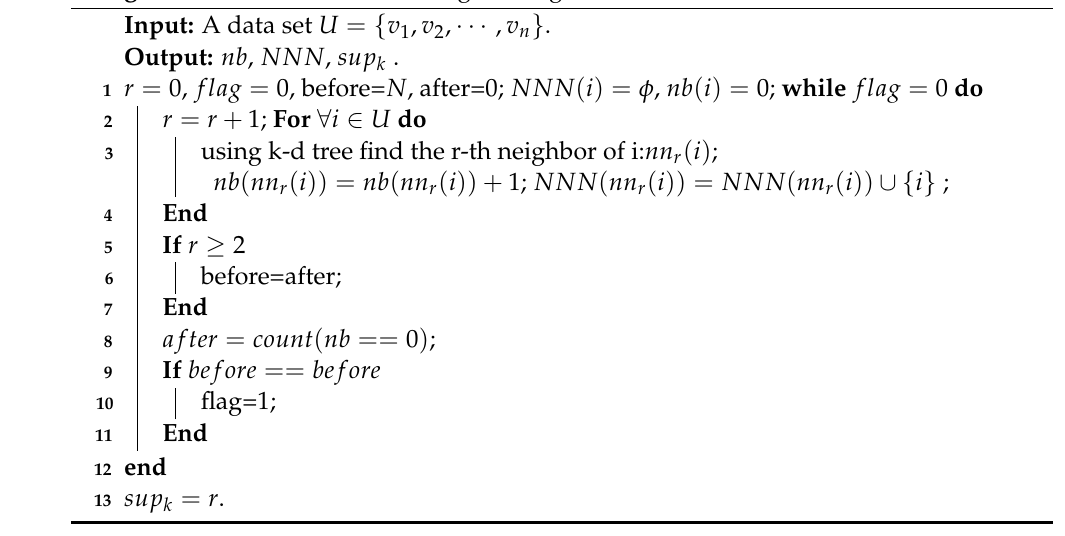
Algorithm 1: Natural nearest neighbor algorithm.